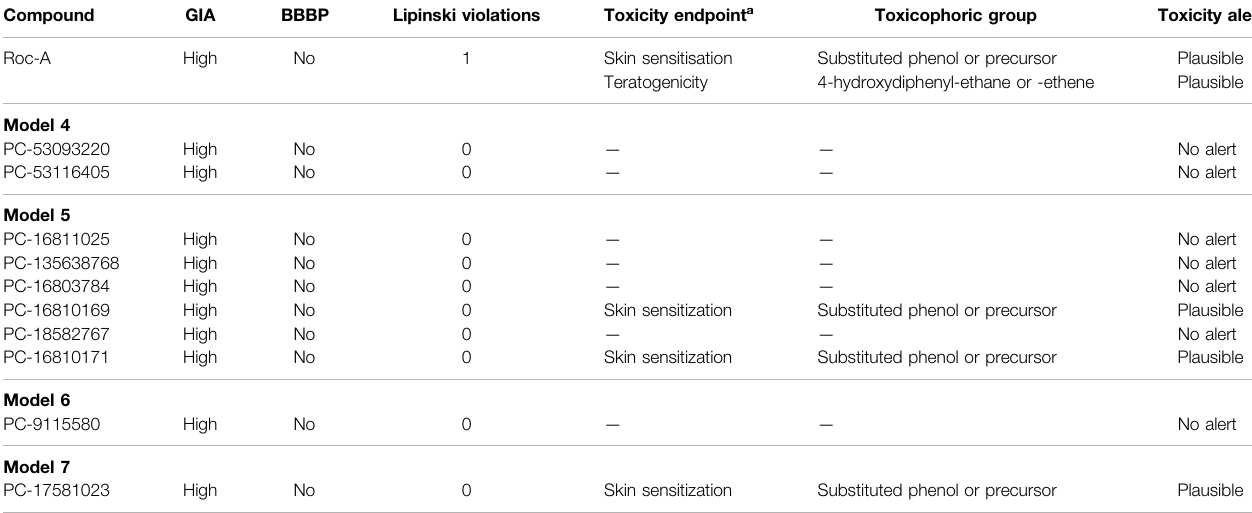
TABLE 9| Predictionoftoxicityand pharmacokineticpropertiesfor 10selected compounds, outoftotal of60 retrieved from virtual screening, using DEREK and SwissADME, respectively.